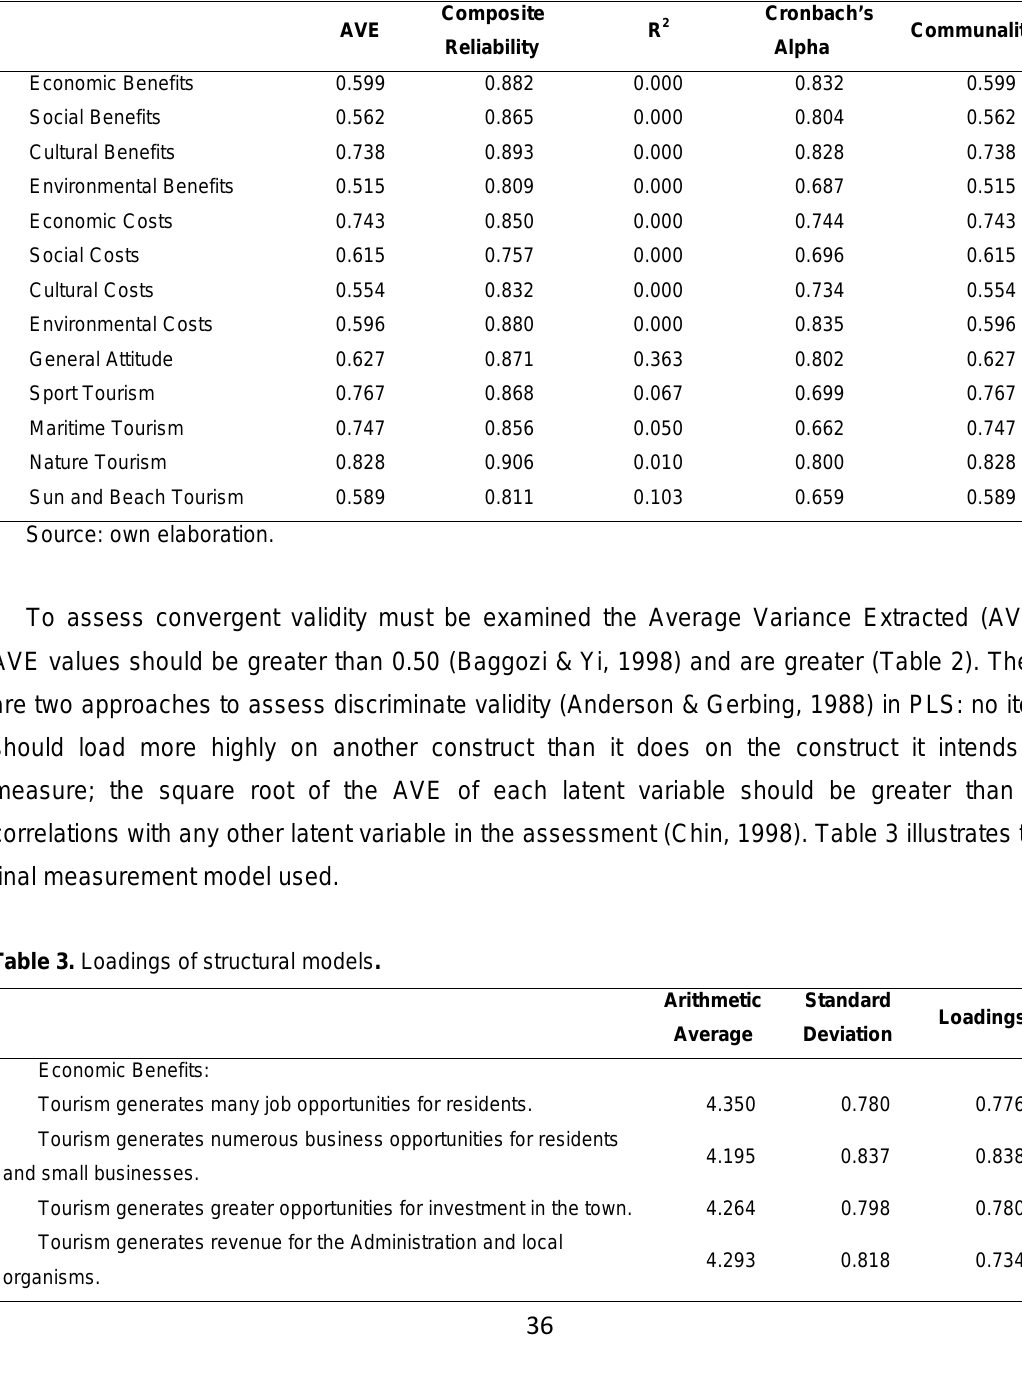
Table 2 that values for Cronbach’s Alpha and Composite Reliability are acceptable. Table 2. Reliability and Convergent Validity